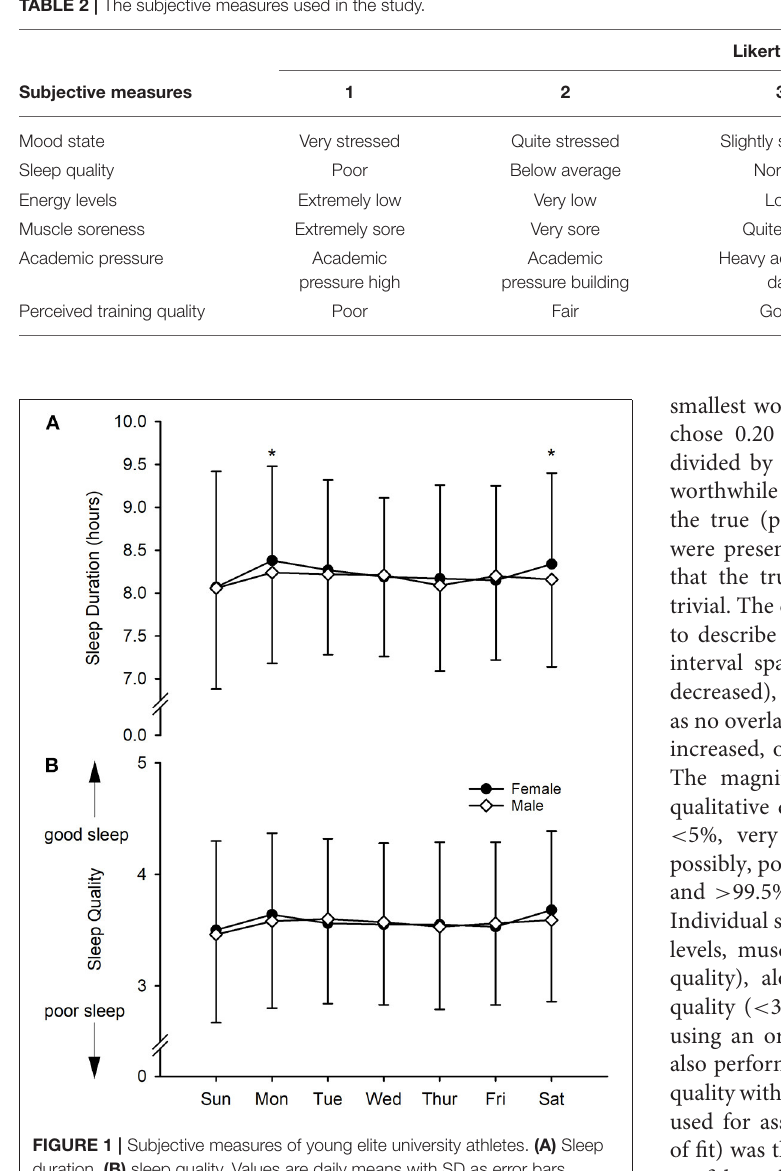
TABLE 2 | The subjective measures used in the study.